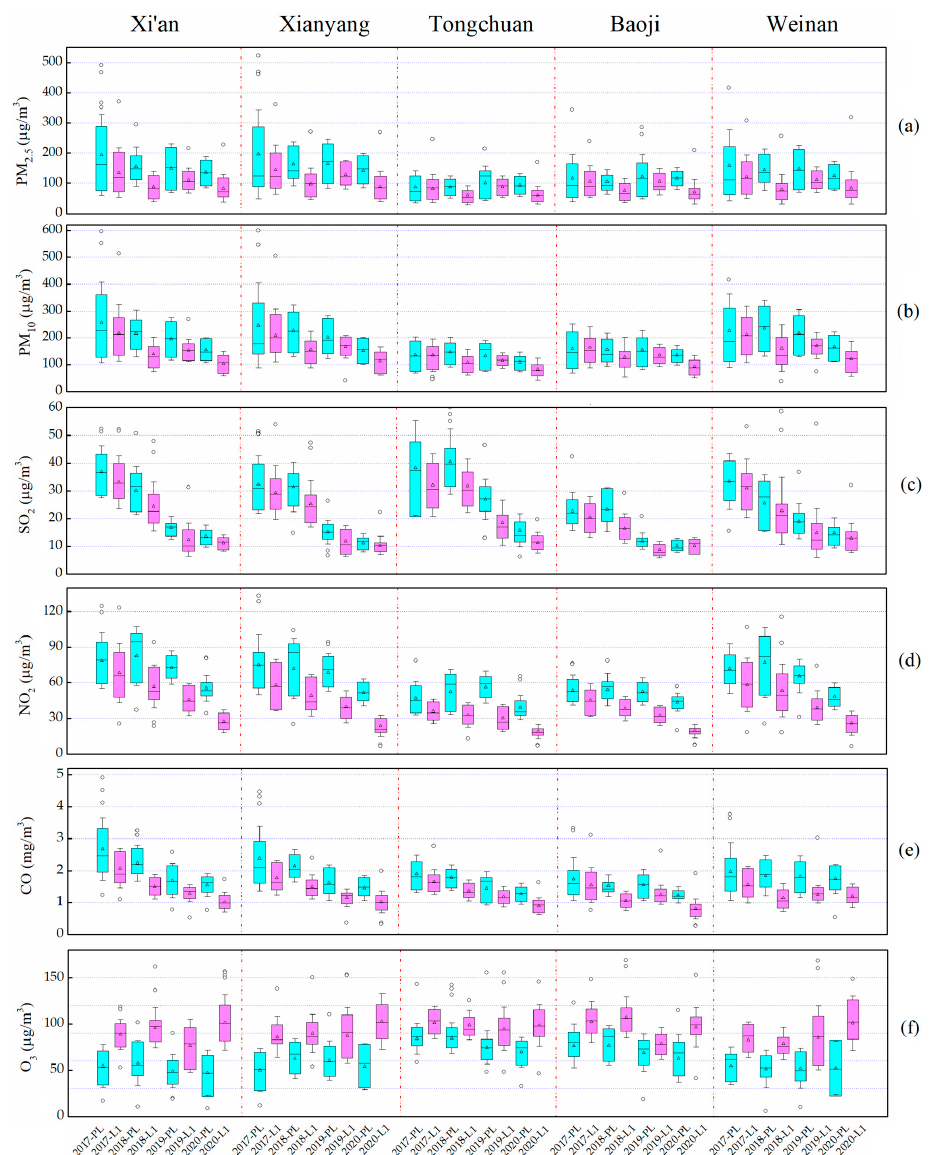
Figure 5. Box plots of the PM 2.5 ( a ), PM 10 ( b ), SO 2 ( c ), NO 2 ( d ), CO ( e ) and O 3 ( f ) concentrations averaged over all ground-based monitoring stations in five cities (indicated on the top) in the Guanzhong Basin during the Pre-lockdown (PL, the blue boxes) and the Level-1 (L1, the purple boxes) stages, from 1 January to 27 February, for each of the years from 2017 to 2020. See Figure 3 for explanation of the boxes. Note the different vertical scales for each species.